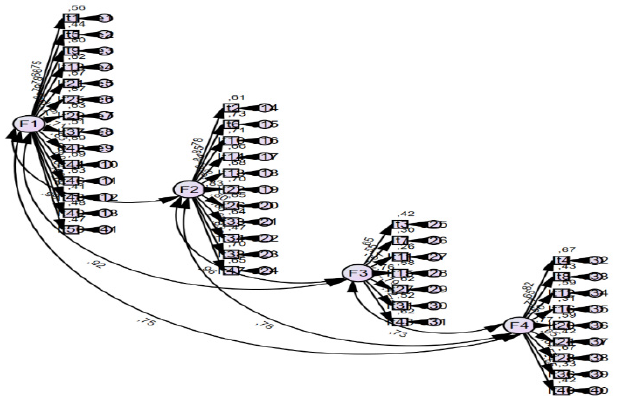
Figure 1. Confirmatory factorial model of the EAFAA-PT with 4 factors and 41 items, adjusted to the sample under study (n* = 500).